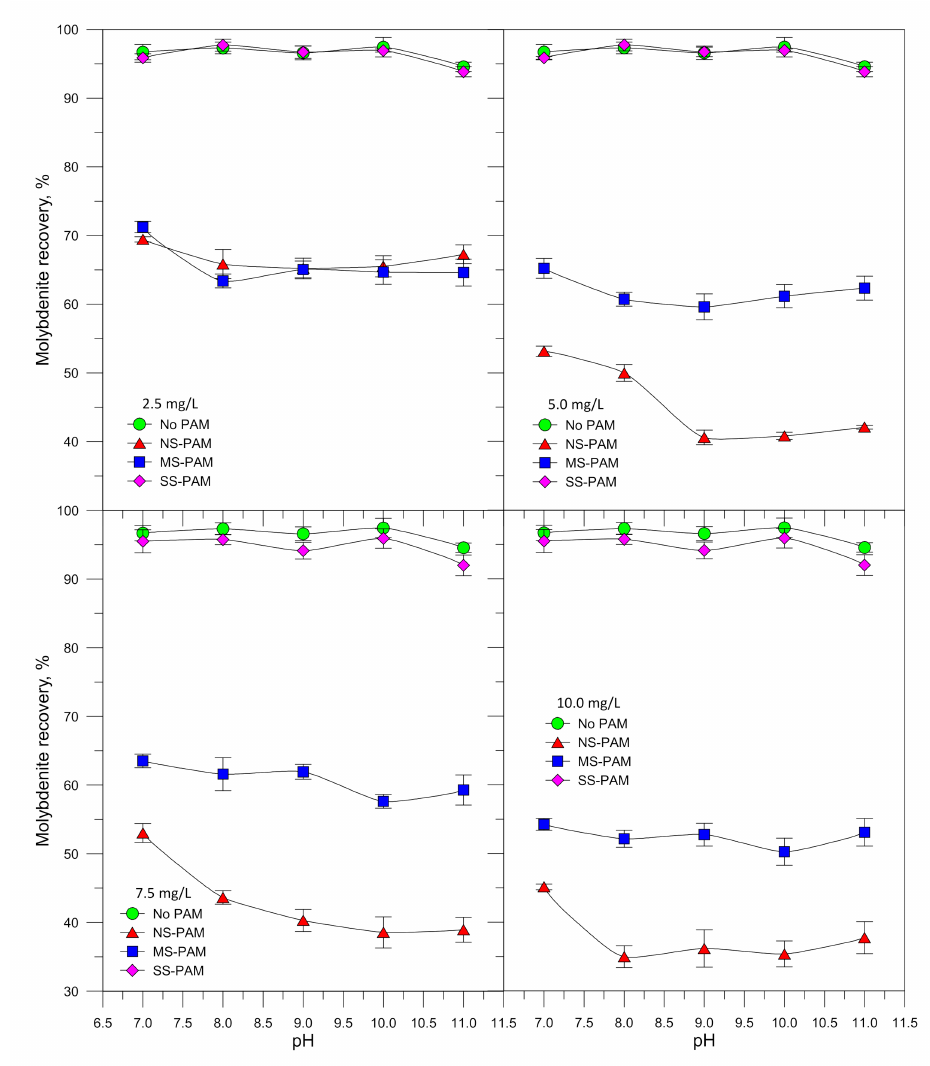
Figure 5. Recovery of molybdenite as a function of pH in the presence of 2.5, 5.0, 7.5, and 10.0 mg / L of NS-PAM, MS-PAM, and